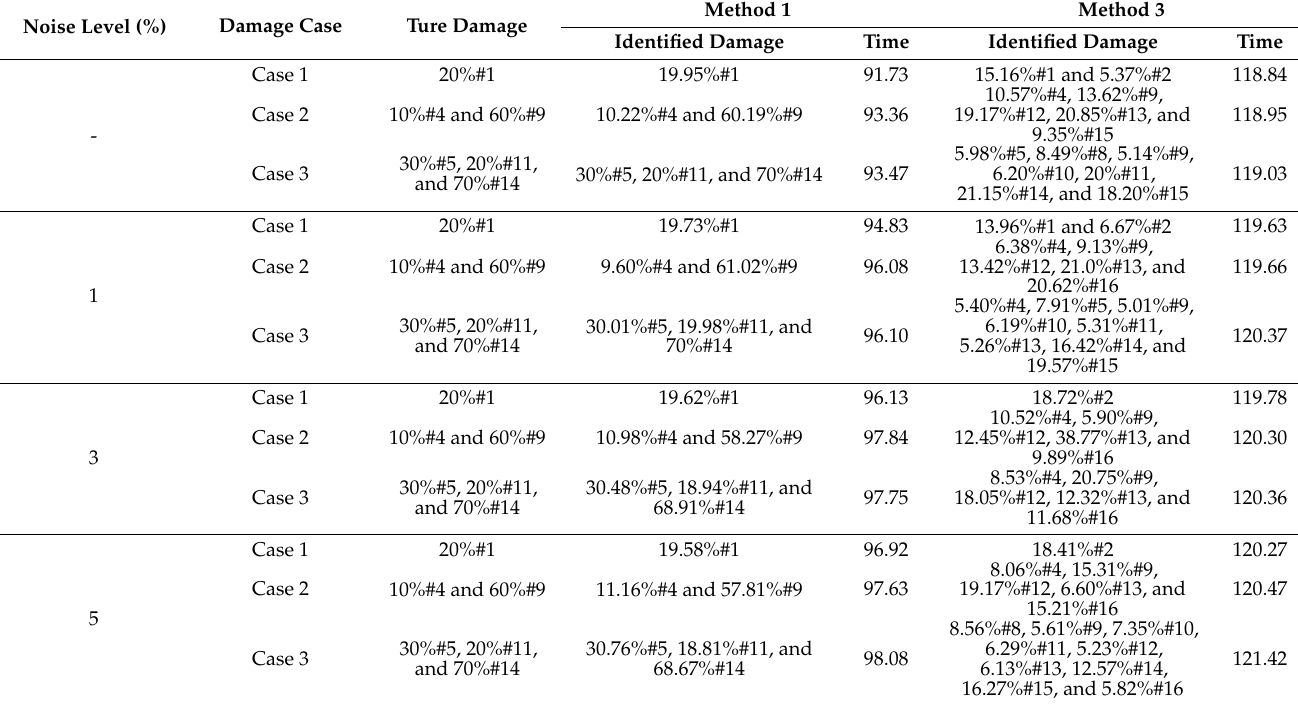
Table 5. The comparative results of damage